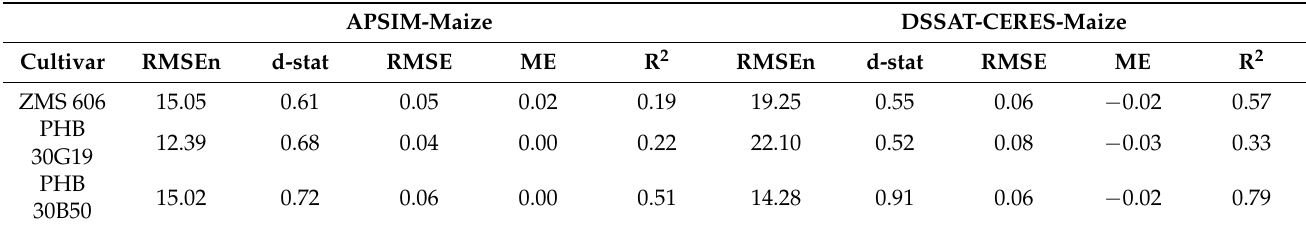
Table 10. The APSIM-Maize and DSSAT-CERES-Maize model calibration statistics for the grain unit wt. for the maize cultivars under rainfed conditions.